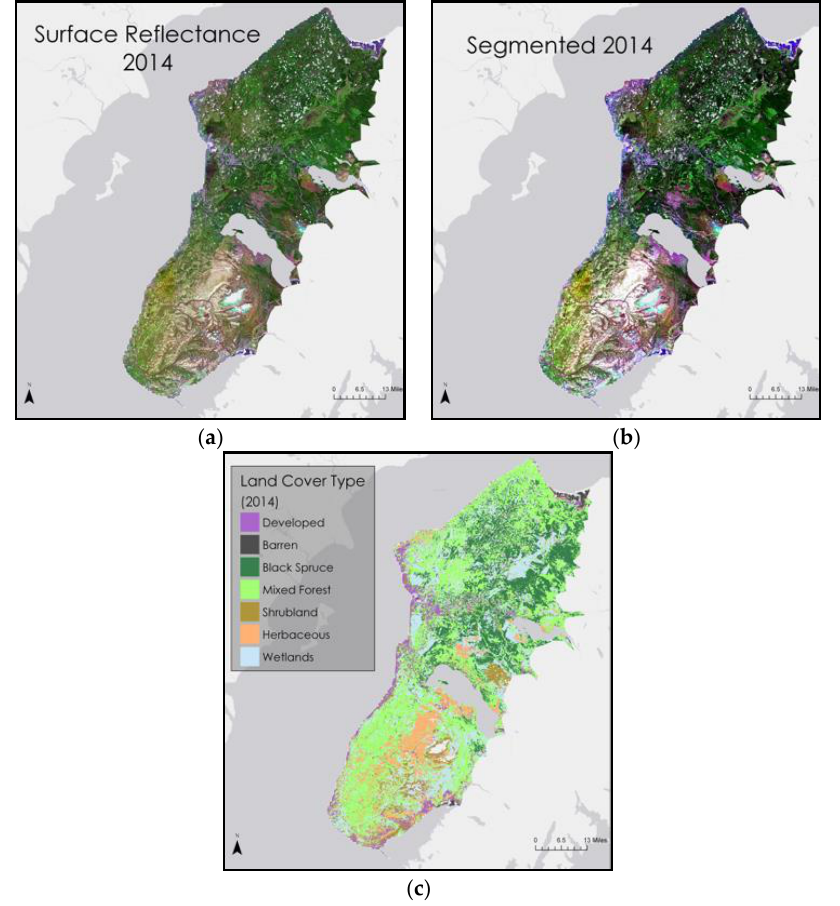
Figure 2. The land cover classification process for 2014 imagery. ( a ) True color composite from 4 May 2014; ( b ) The result of running image ( a ) through a Segment Mean Shift tool, which groups pixels into segments based on their spectral signatures; ( c ) The result of a vector-supervised machine classification, showing seven land cover classes.